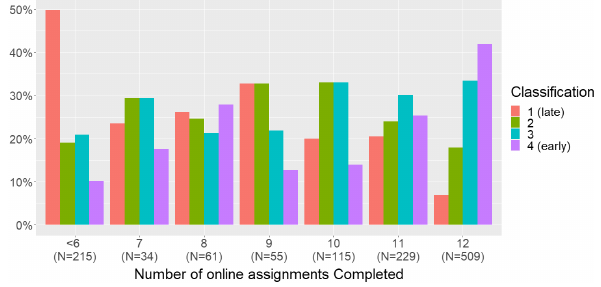
FIG. 6. Proportion of students in each classification group by the number of online assignments the student completed.